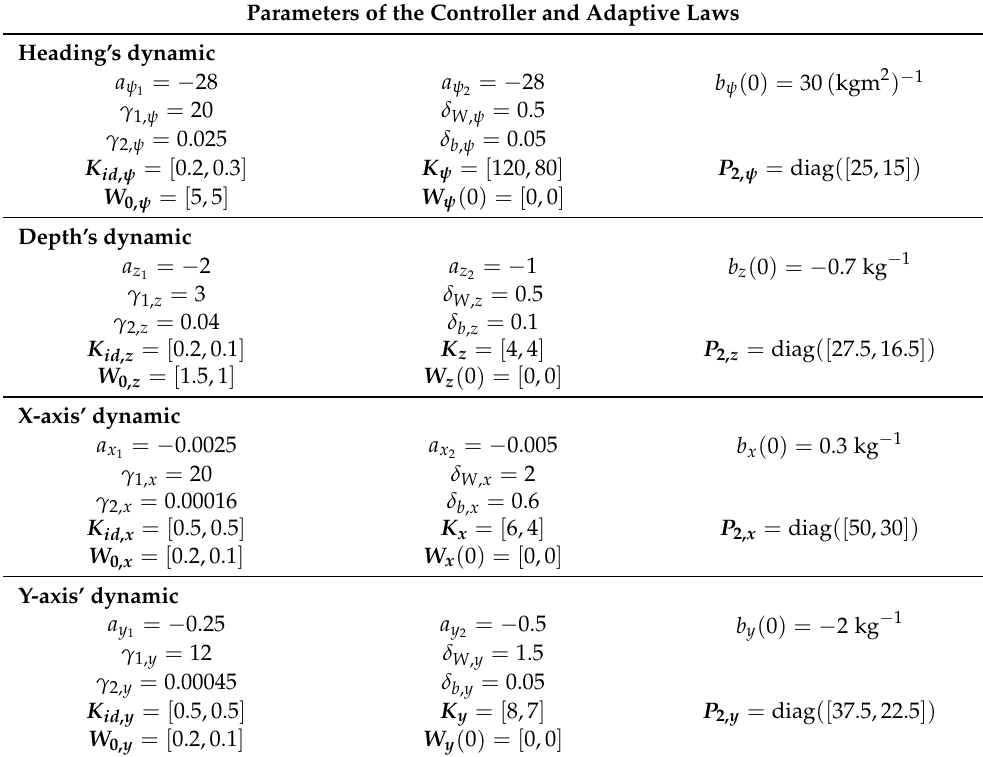
Table 2. Controller gains and adaptive law parameters used in the simulation